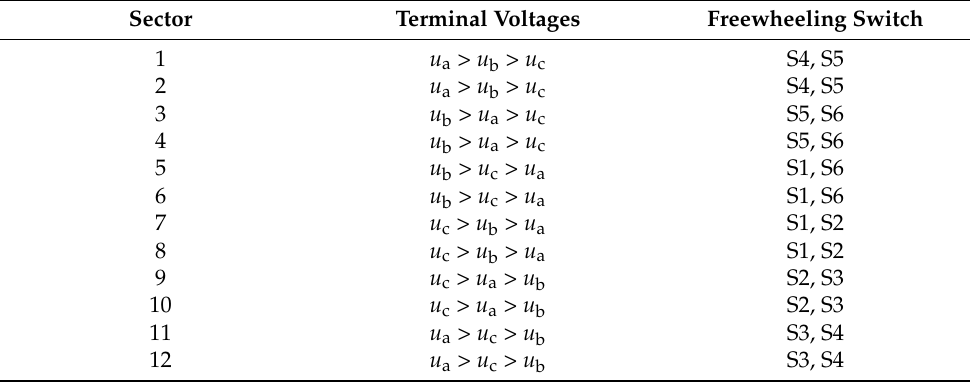
Table 3. Freewheeling switch in each